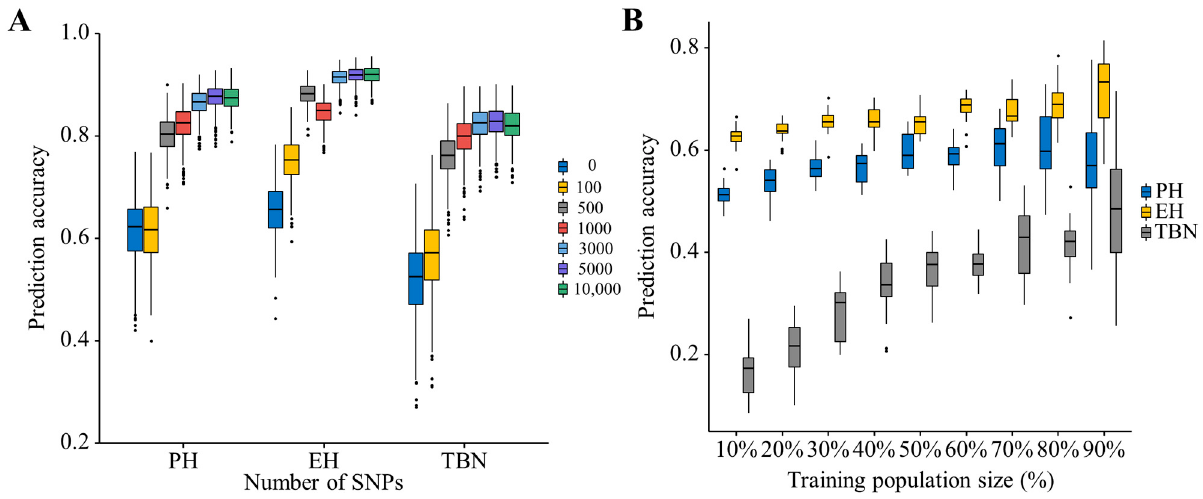
Figure 9. Genomic prediction accuracy of PH, EH, and TBN in the population, ( A ) when the number of SNPs varied from 0 to 10,000. ( B ) when the training population size (TPS) ranged from 10 to 90% of the total population size.